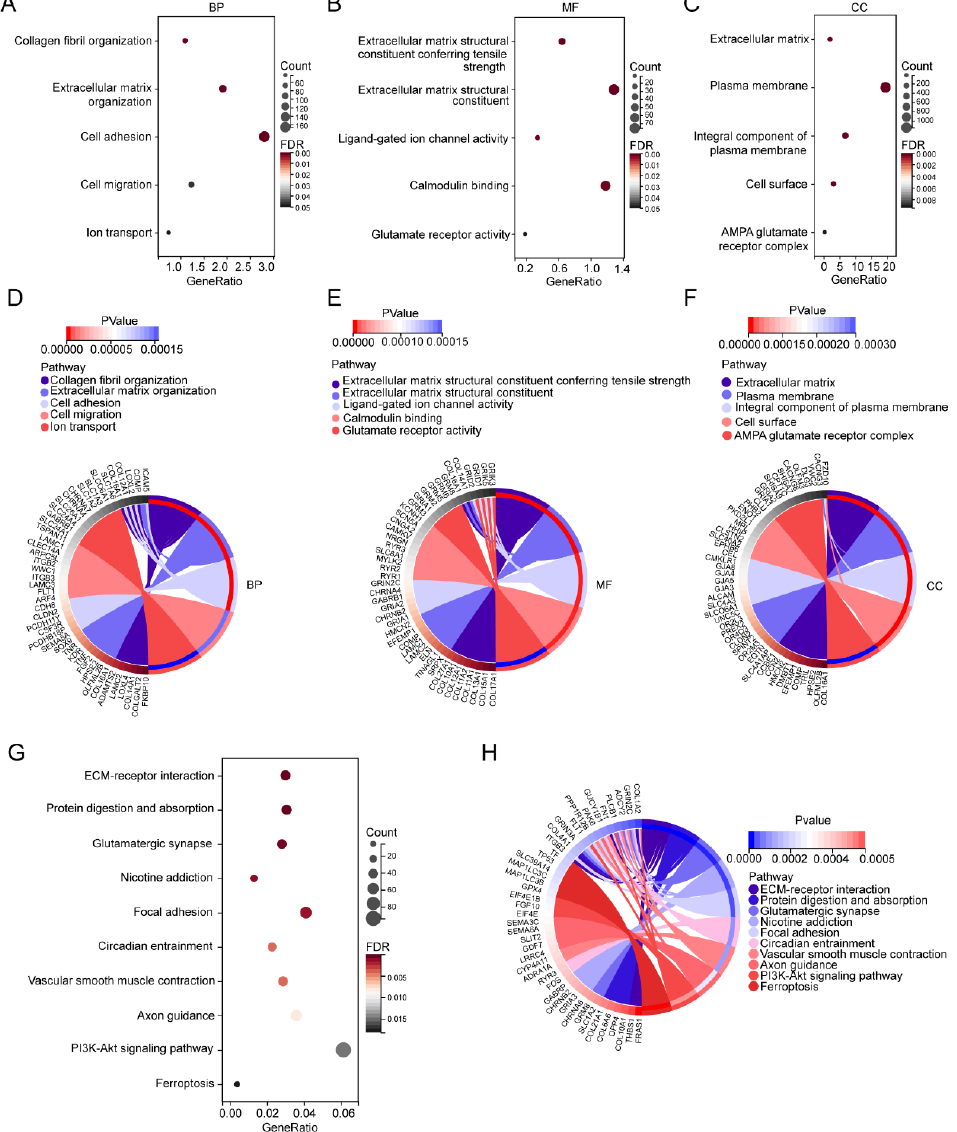
Figure 3. GO and KEGG enrichment analyses of the DEGs. ( A ) Bubble plots of the biological process of the GO analysis. ( B ) Bubble plots of the molecular function of the GO analysis. ( C ) Bubble plots of the cellular component of the GO analysis. ( D ) Circle plot and network visualizing the biological process of the GO analysis. ( E ) Circle plot and network visualizing the molecular function of the GO analysis. ( F ) Circle plot and network visualizing the cellular component of the GO analysis. ( G ) Bubble plot of the KEGG pathway enrichment of the DEGs. ( H ) Circle plot and network visualizing the KEGG pathway.